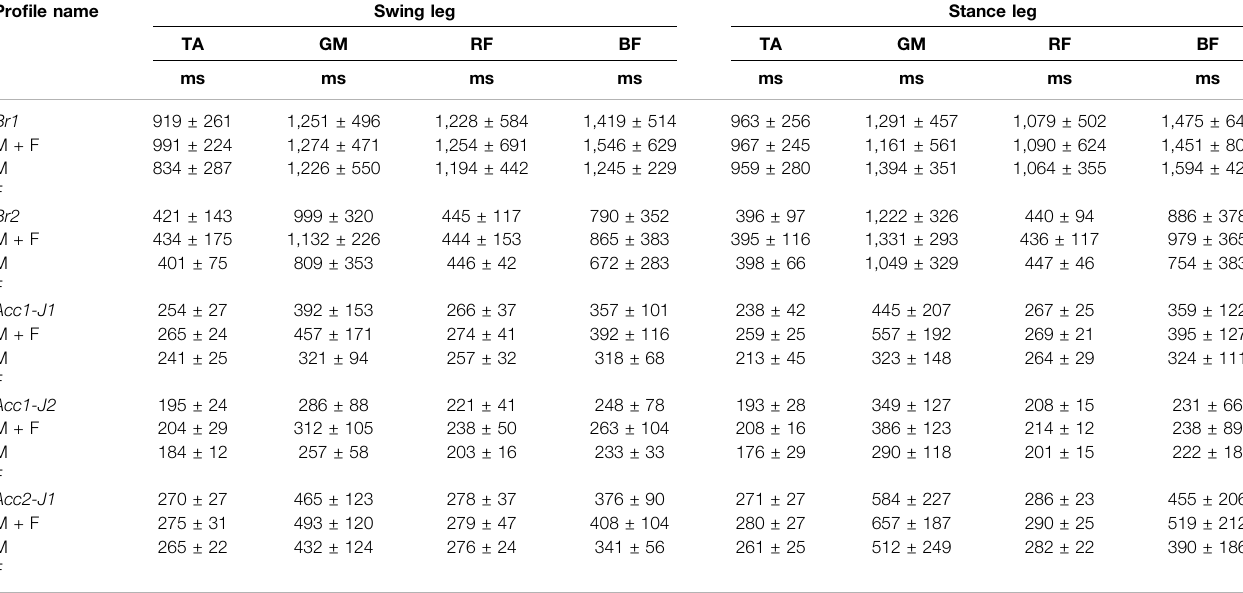
TABLE 5 | Descriptive statistics on EMG onset latencies in forward-direction trials (Males/Females, mean ± SD). Pro fi le name